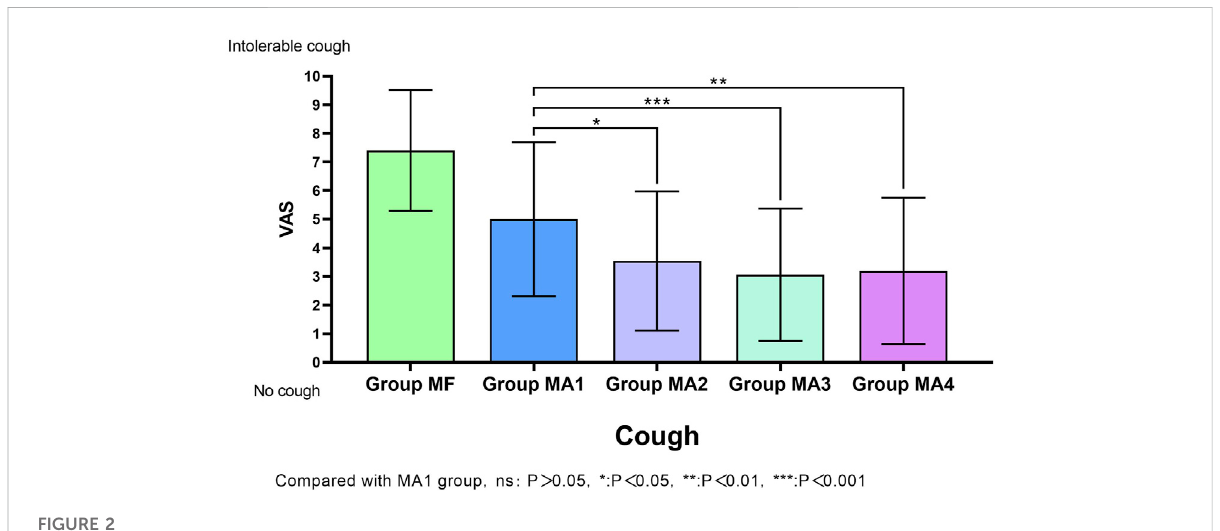
FIGURE 2 Visual analogue scale (VAS) scores of cough in fi ve groups.